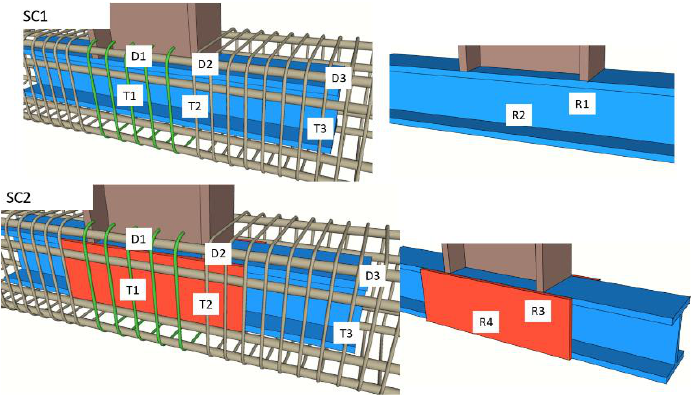
Figure 6. Strain gauge (D and T) and rosette (R) locations.